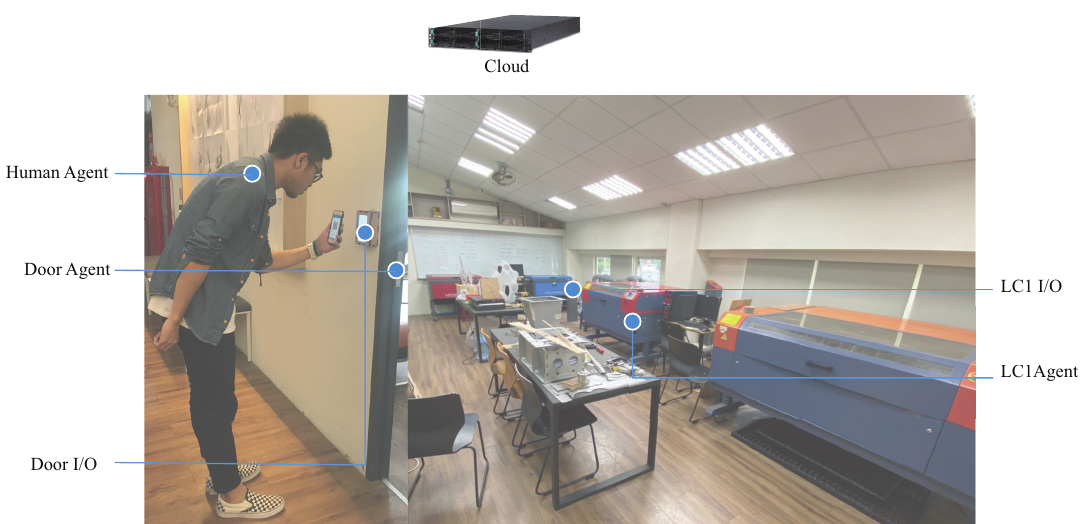
Figure 4. Agent communication in the co-making